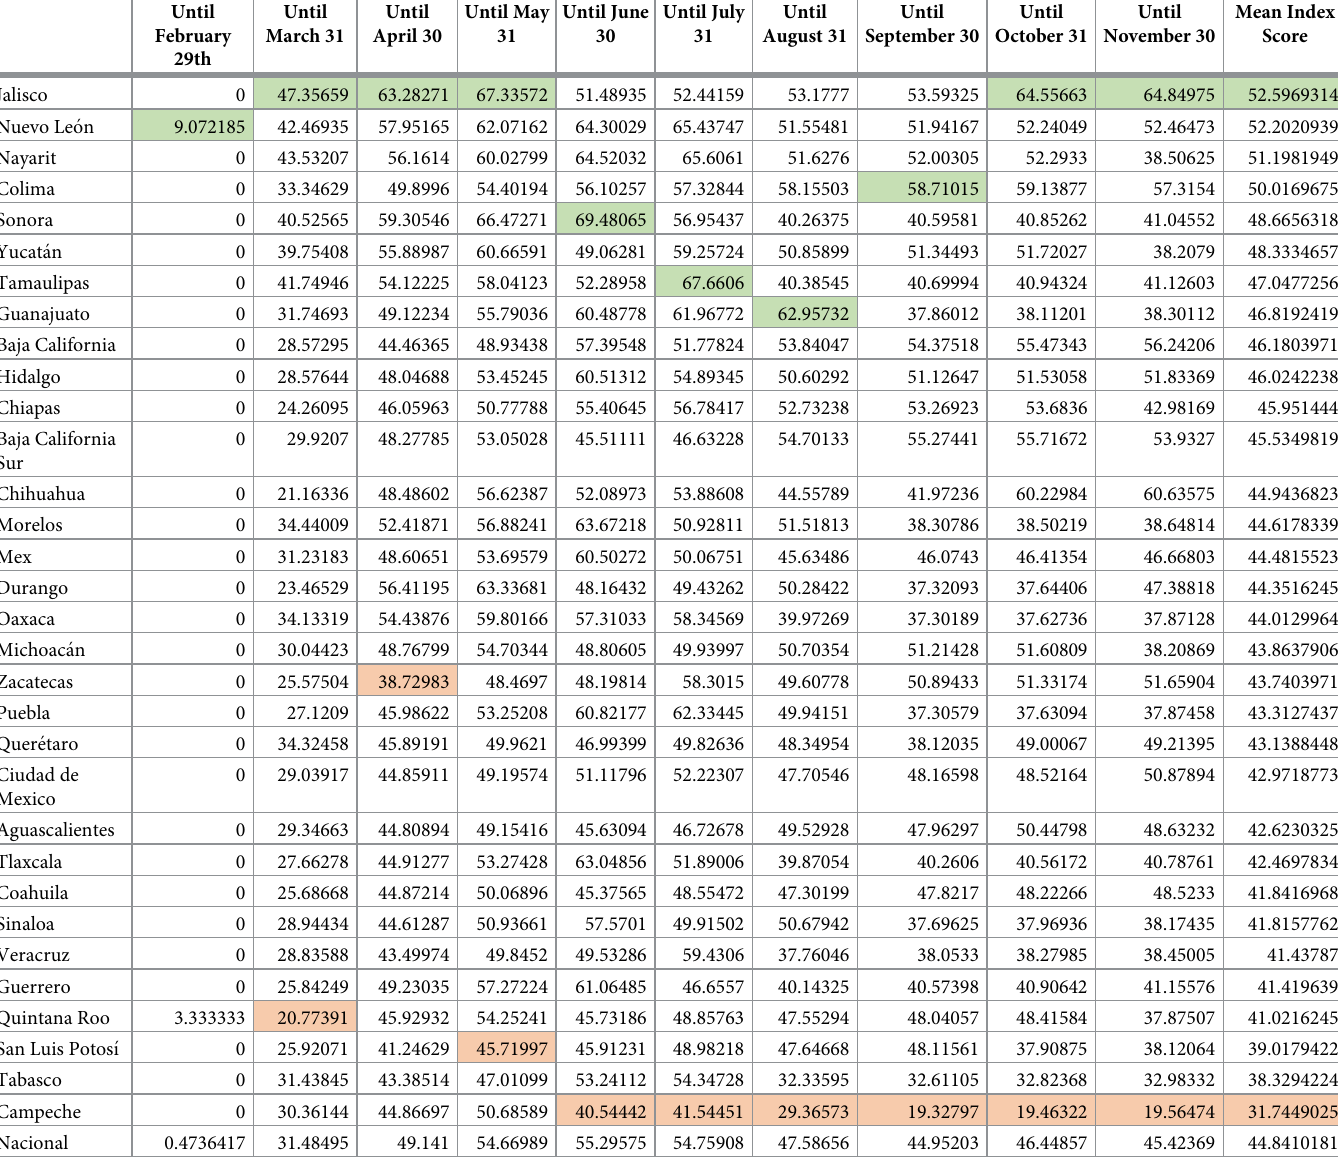
Table 4. Index scores for physical distancing policy adoption and containment of COVID-19 in Mexico by state. From February 27 to November 30, 2020. Until